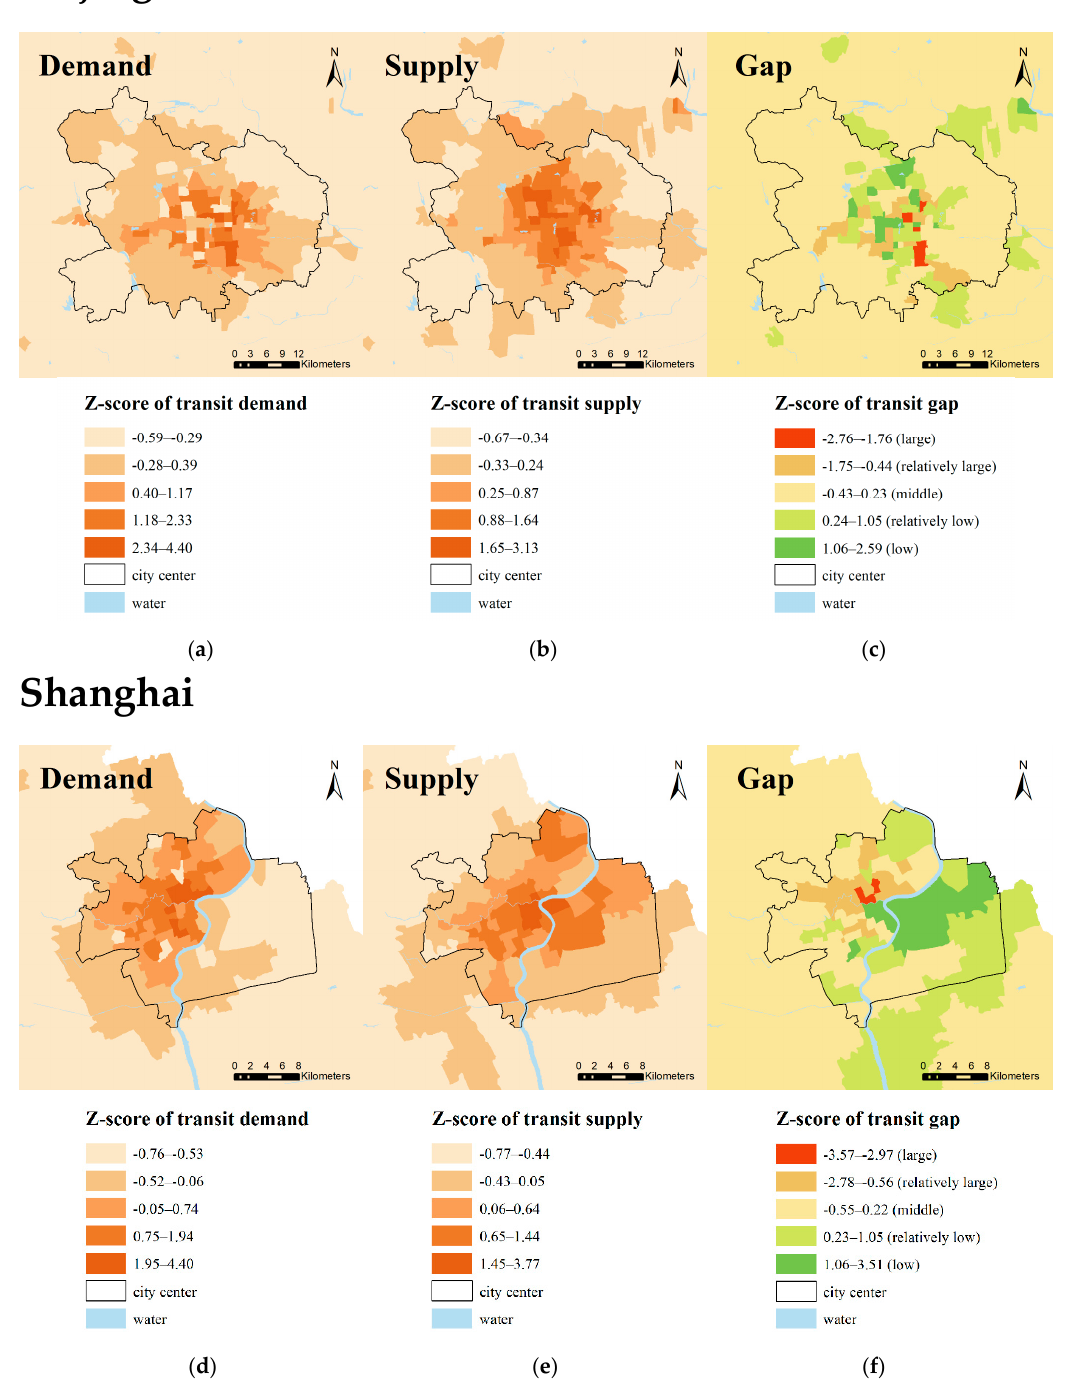
Figure 2. Transit gaps between supplies and demands in Beijing and Shanghai: ( a ) transit demands in Beijing; ( b ) transit supplies in Beijing; ( c ) transit gaps in Beijing; ( d ) transit demands in Shanghai; ( e ) transit supplies in Shanghai; ( f ) transit gaps in